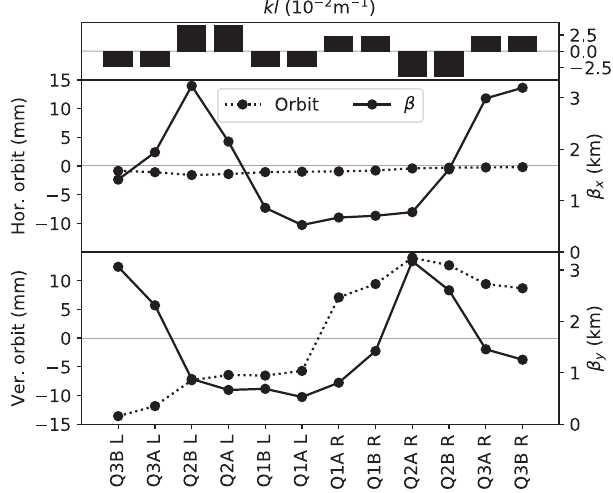
FIG. 6. Integrated quadrupolar strength ( kl ), orbit and β - functions across the triplet of IR1 with β (cid:1) ¼ 1 m optics.